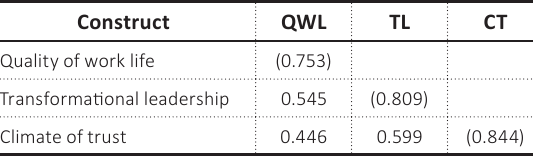
Table 3. Discriminant validity